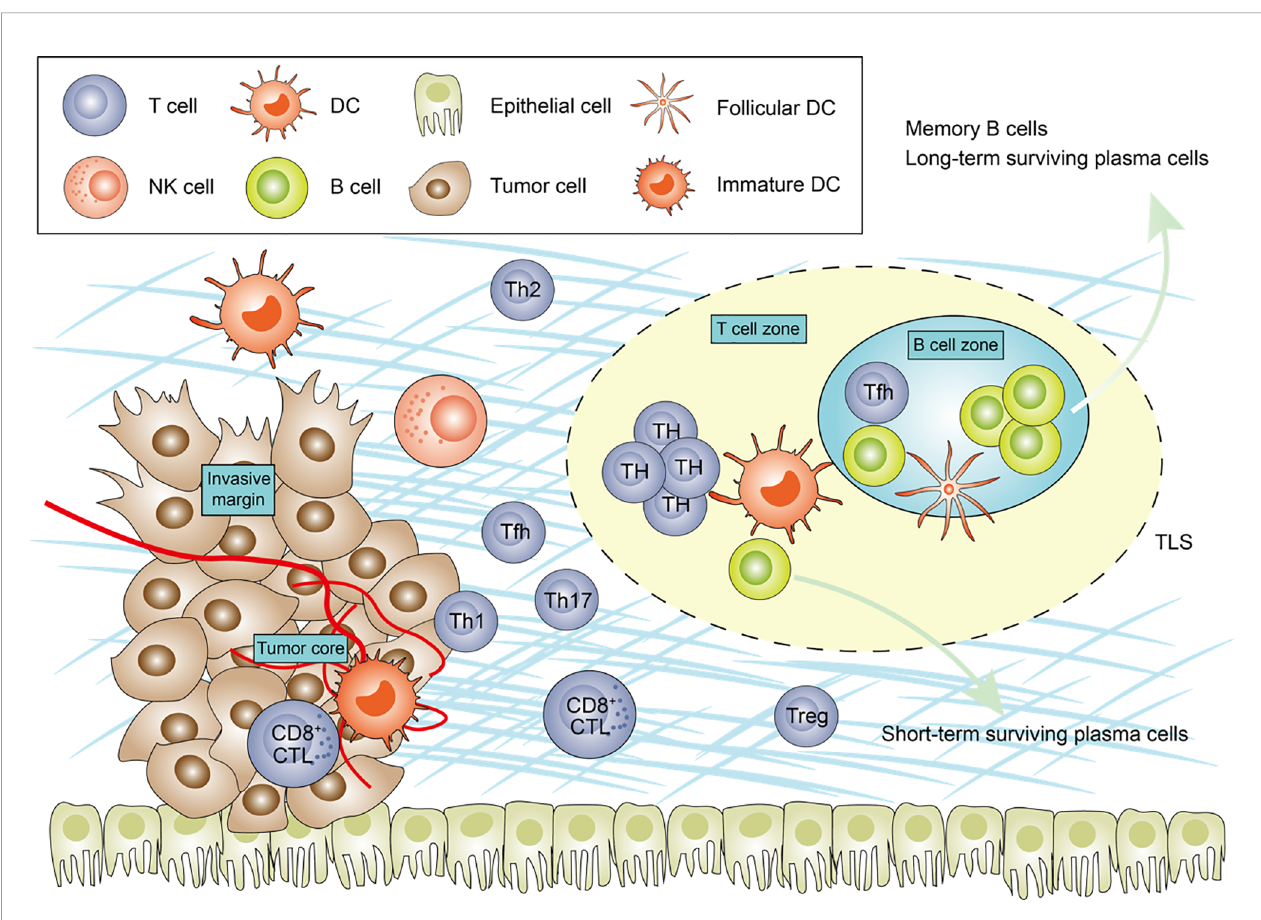
FIGURE 1 | The main tumor-in fi ltrating lymphocytes and tertiary lymphoid structures components in cancer. The schematic representation shows the features of the immune contexture, including tumor-in fi ltrating lymphocytes and tertiary lymphoid structures (TLSs). TLSs are usually located in the invasive margin or in the stroma rather than the tumor core. Tfh cells are the most important sources of CXCL13, induced TLSs formation. Th17 cells, B cells have been shown to be able to initiate of TLSs genesis in various pathological contexts. The synergistic effect of CD8 + cytotoxic effector T cells and B cells, generated in TLS, enable to direct kill tumour cell. Central memory B cells generated in TLSs protect against metastasis. TH, T helper cell; Treg, regulatory T cell; Tfh, follicular helper T; CTL, cytotoxic T cells; DC, dendritic